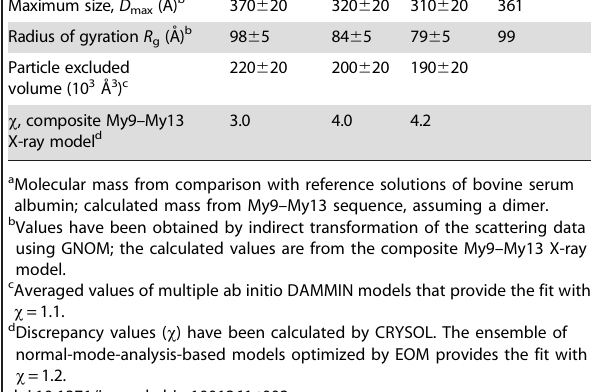
Table 2. Solution X-ray scattering data statistics.